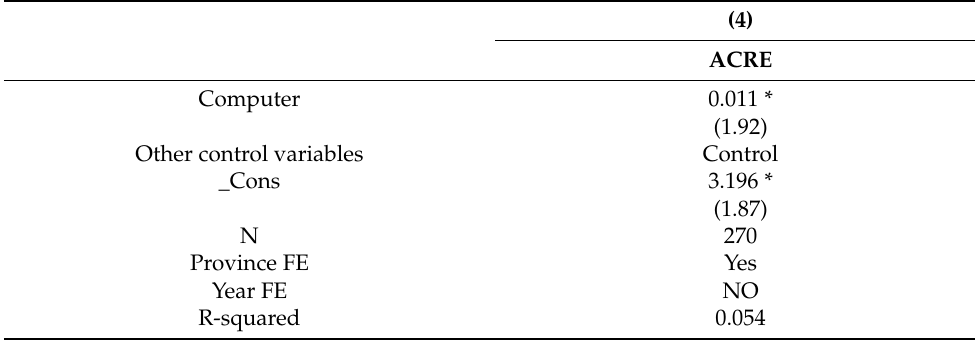
Table 5. Robustness analysis: Replacing the main independent